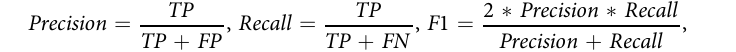
Positive and negative samples.